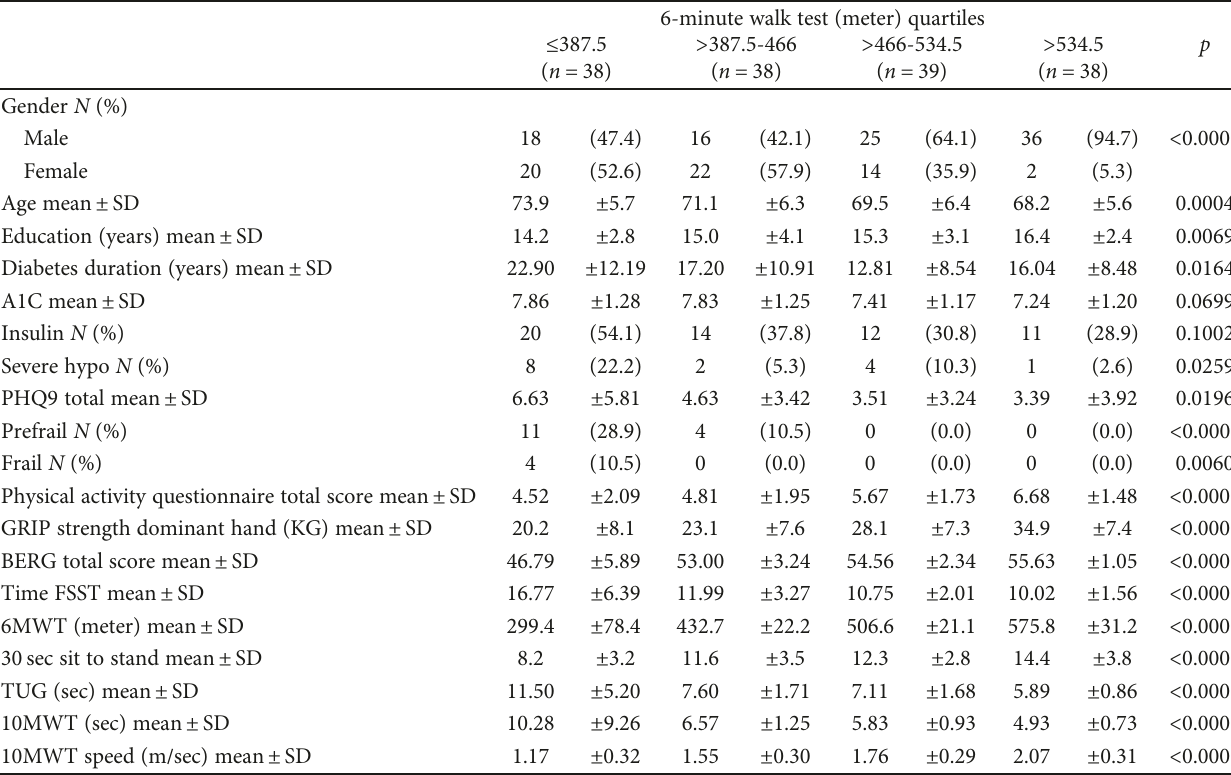
Table 1: Characteristics of study population ( N = 153 ).